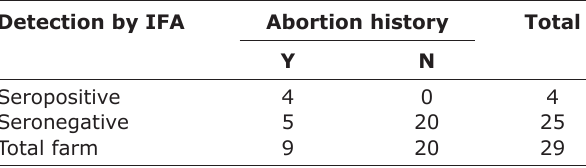
Table-3: The association between abortion history and Q fever infection from 29 farms. Detection by IFA Abortion history